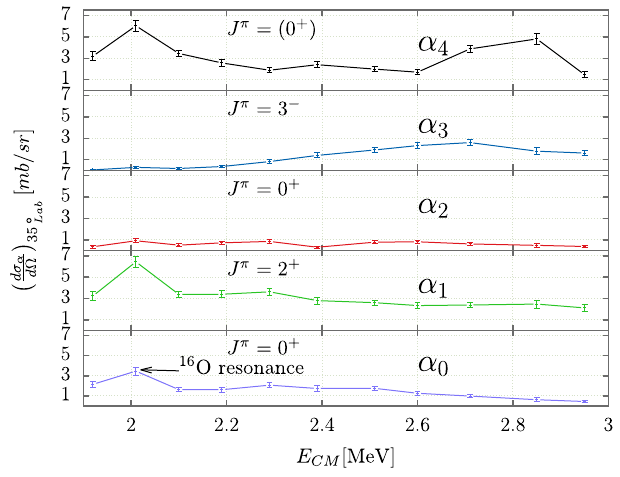
FIG. 11. Differential cross section at 35° in the laboratory system for alpha decays to the lowest lying 12 C nuclear states, statistical error bars are also shown (the average error is around 15% with a minimum of 8% and maximum of 35%, no systematic errors are reported). Quantum numbers (spin and parity) of each state are given. The lines are drawn to guide the eye.